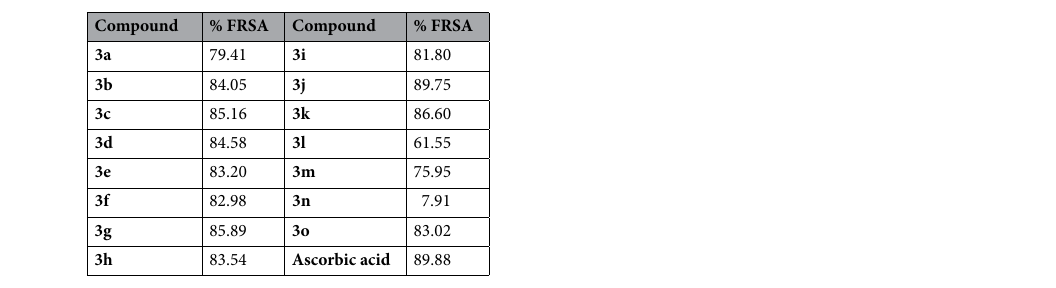
Table 2. The percent free radical scavenging activity of 3a - o . DPPH free radical scavenging activity expressed as percent free radical scavenging activity (% FRSA). Synthesized compounds’ codes were written in bold